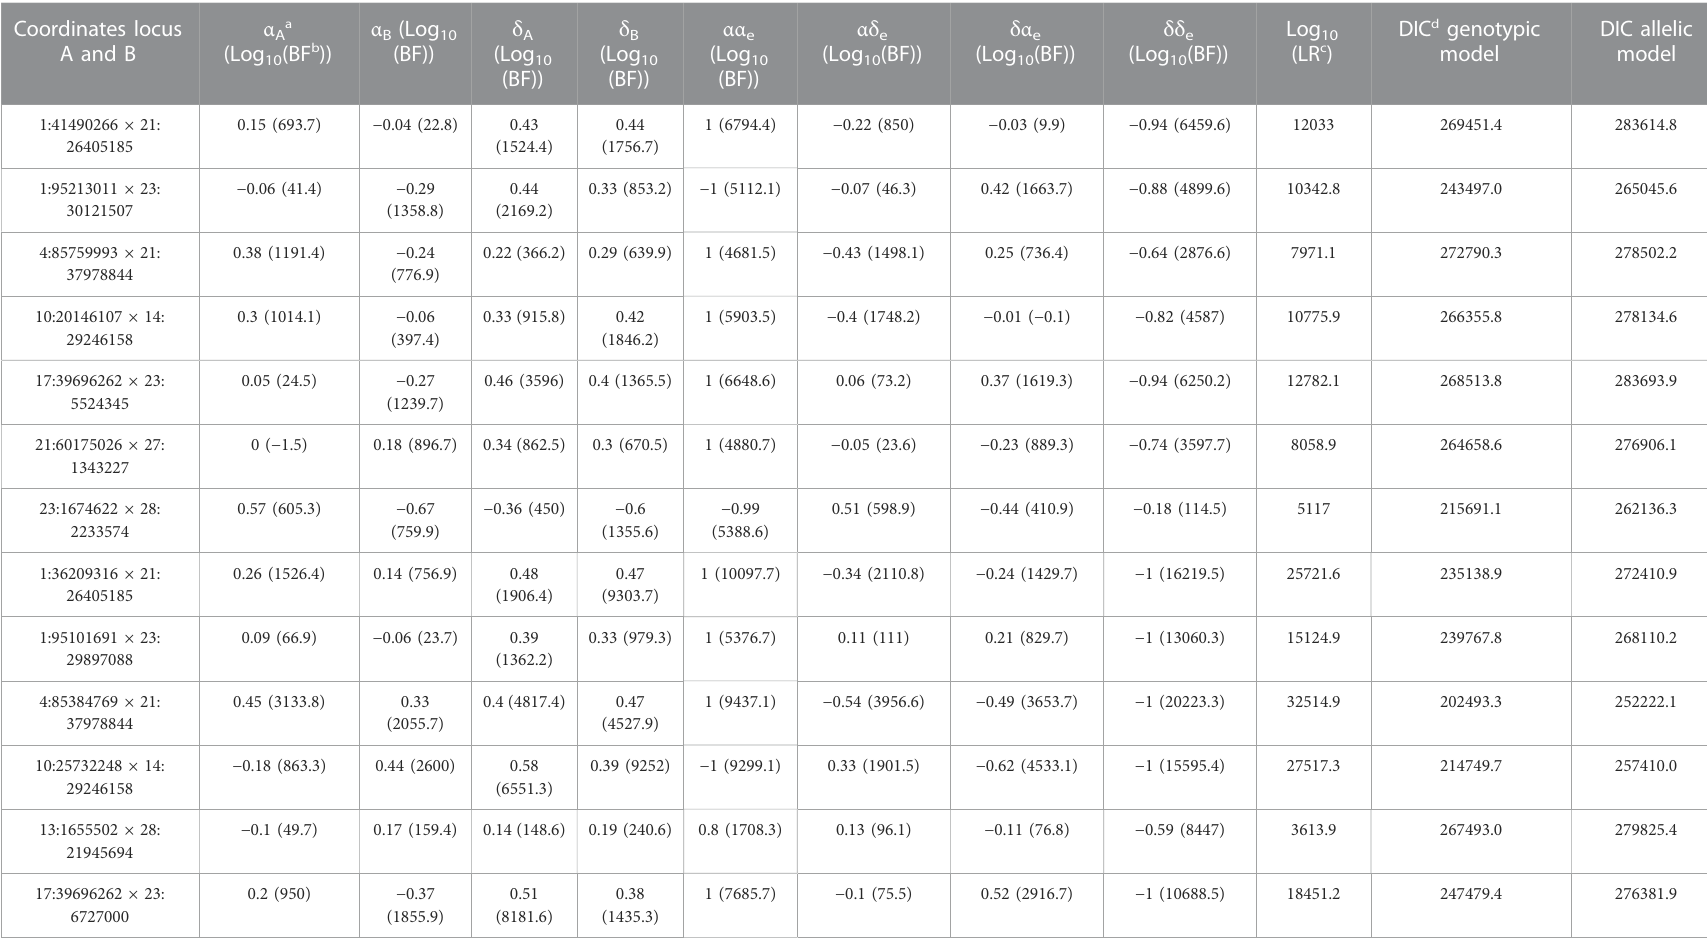
TABLE 1 Pairs of genomic regions identi fi ed with epistatic transmission ratio distortion (TRD) in Holstein cattle with mainly additive-by-additive or dominance-by-dominance effects. Coordinates locus A and